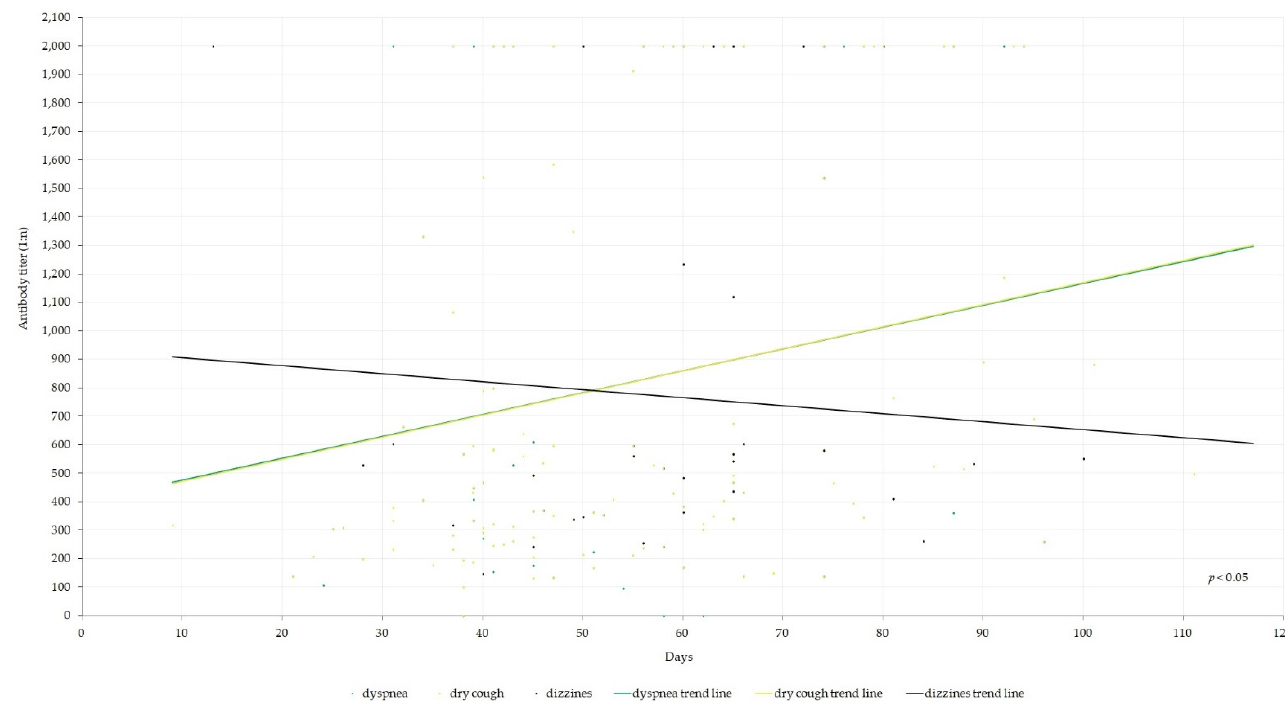
Figure 1. Anti-SARS-CoV-2 antibody titers depending on the symptoms of dizziness, dyspnea, and dry cough. Spots may represent more than one symptom. The chi-square test was used to derive the p -values.